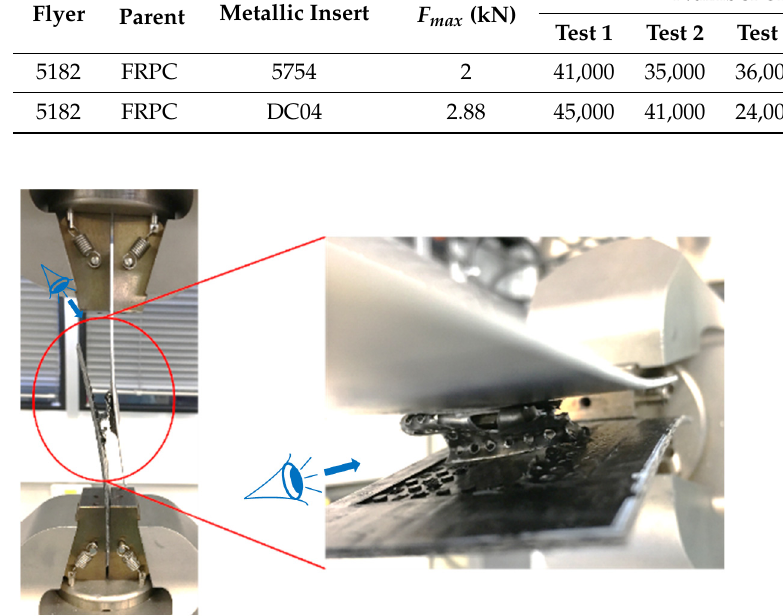
Table 8. Fatigue tests results for metallic insert configuration (E = 16 kJ).